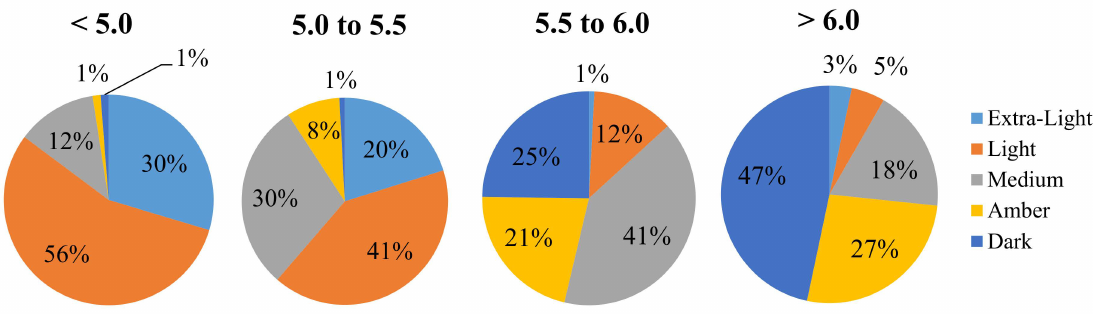
Figure 9. Distribution of syrups according to color grade in different